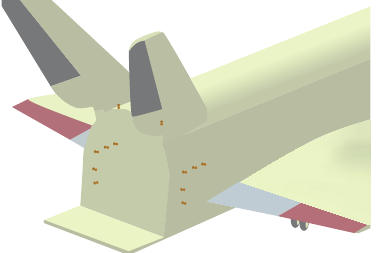
Figure 6: Thrusters longitudinal layout map.